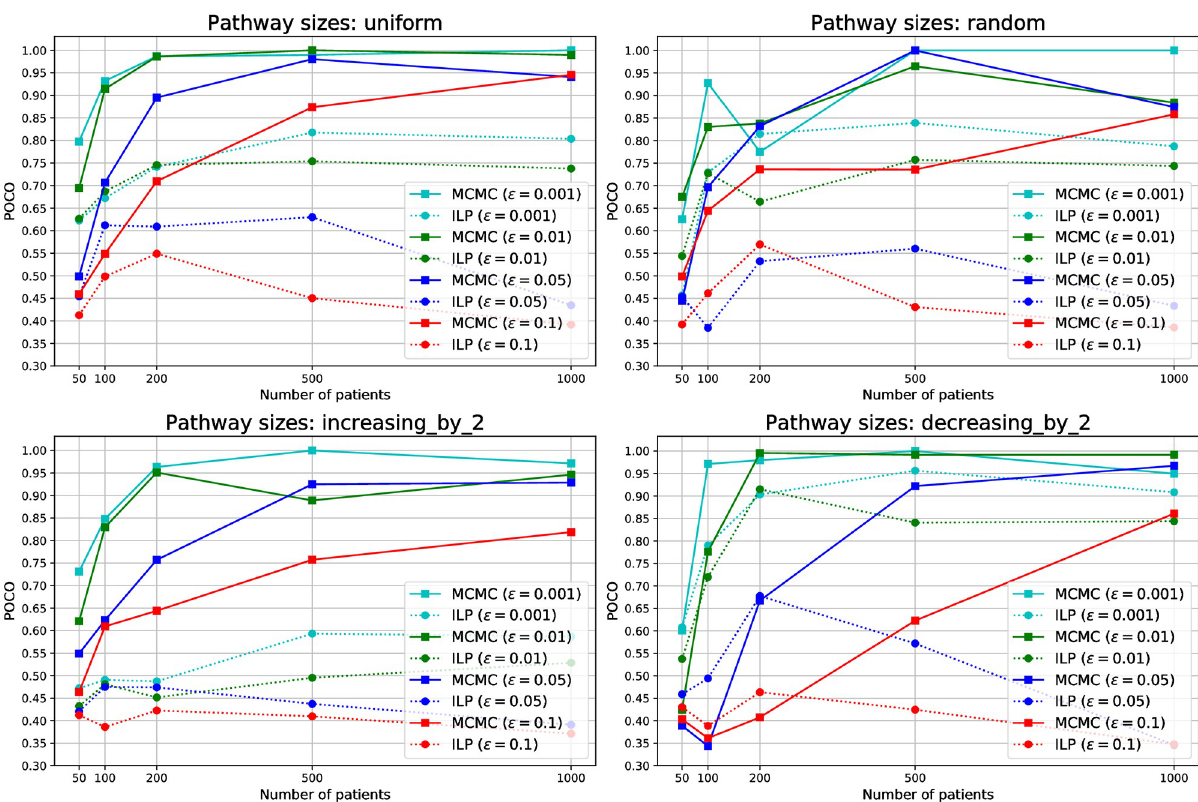
Fig 4. POCO, averaged over 10 datasets, for various � values and pathway size scenarios. The flip-back probability is set to δ = 0.3 in all the datasets.